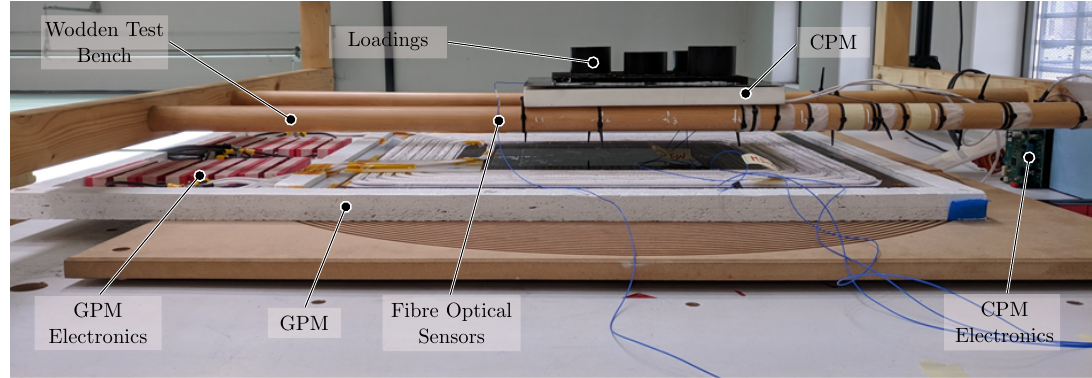
Figure 11. Photograph of the experimental setup of the system level testing exemplary on the sandwich